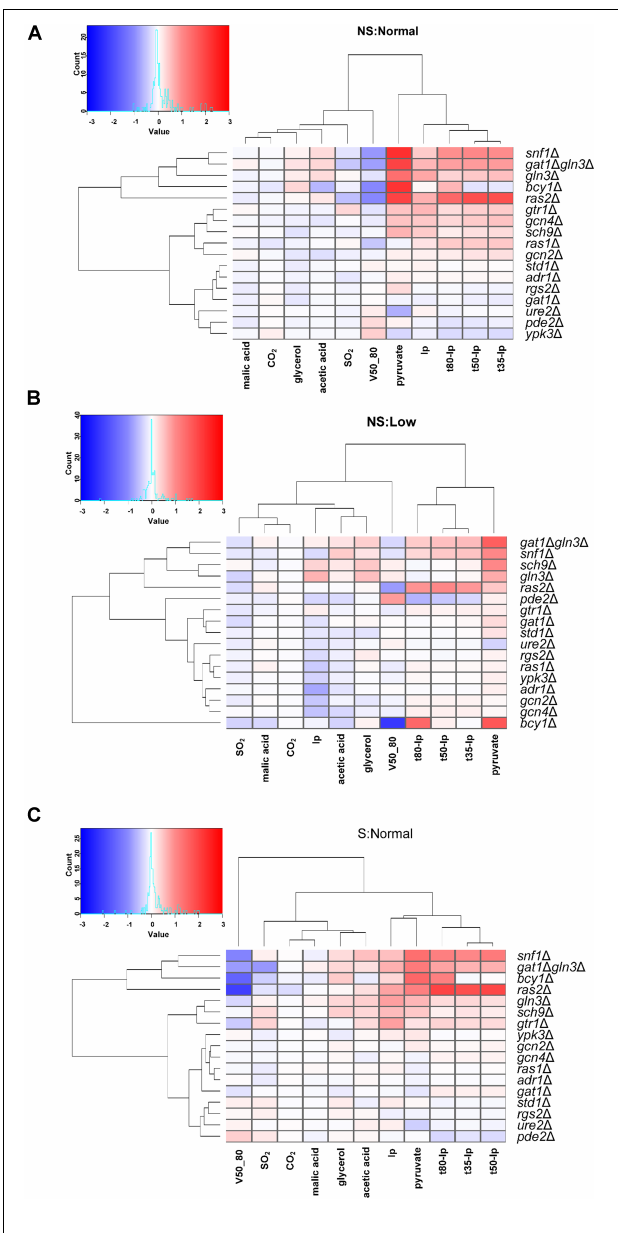
FIGURE 4 | Mutants PKA, SNF1, and NCR had a huge impact on wine fermentations. Heatmaps showing relative changes in the kinetics and end-product concentrations of the selected mutants in relation to their parental strain C9. Conditions in panels (A–C) are explained in Figure 2 .